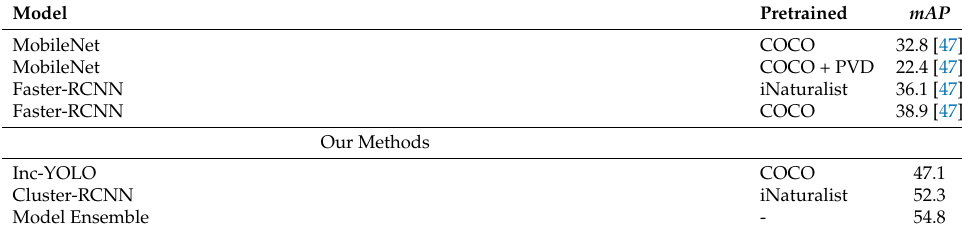
Table 4. Model robustness validation